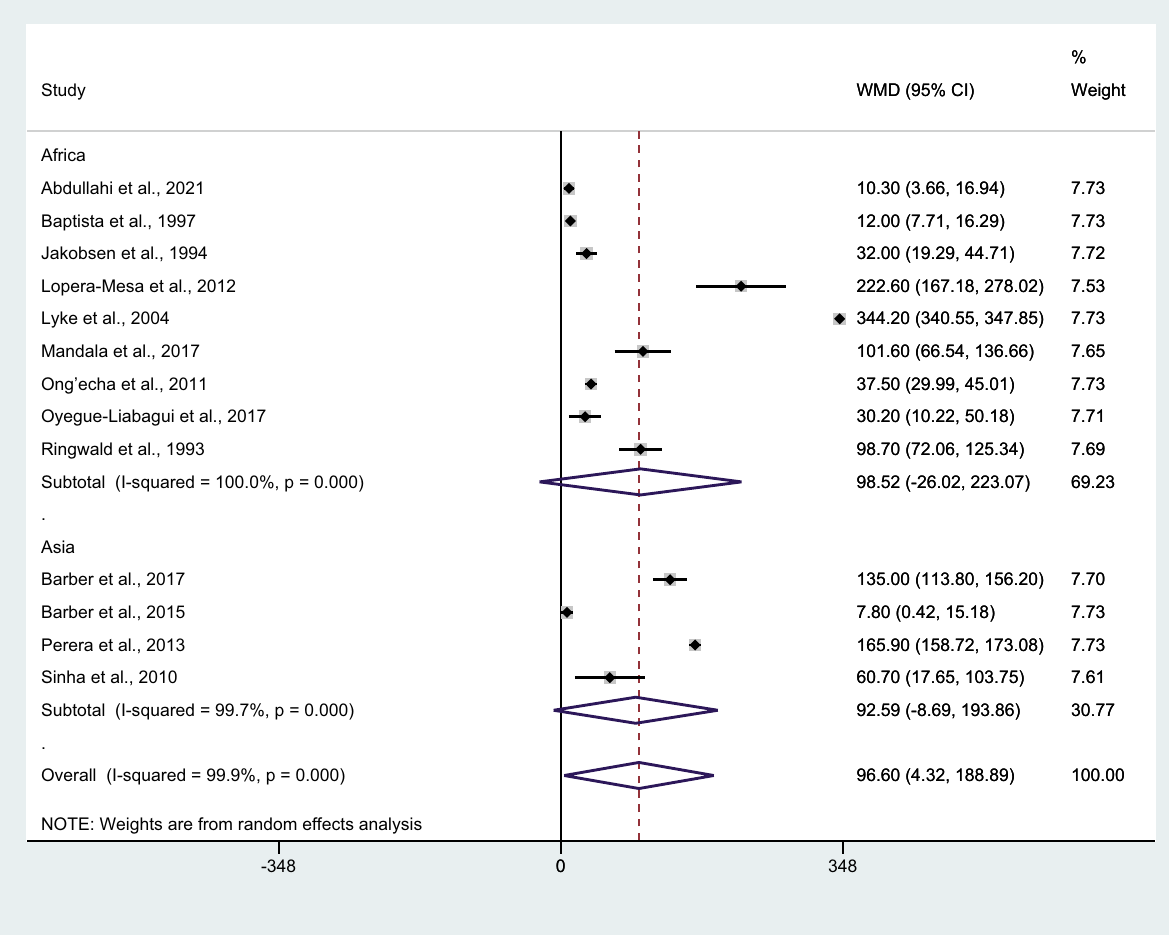
Figure 3. Differences in IL-6 levels between patients with severe malaria and non-severe malaria by continents. Abbreviation: WMD, weighted mean difference; CI, confidence interval; black diamond symbol, point estimate; solid line in the middle of the graph at 0, zero effect size; Dashed red line: pooled WMD between the two groups; I 2 , level of heterogeneity; P = 0.00 or less than 0.05, significant